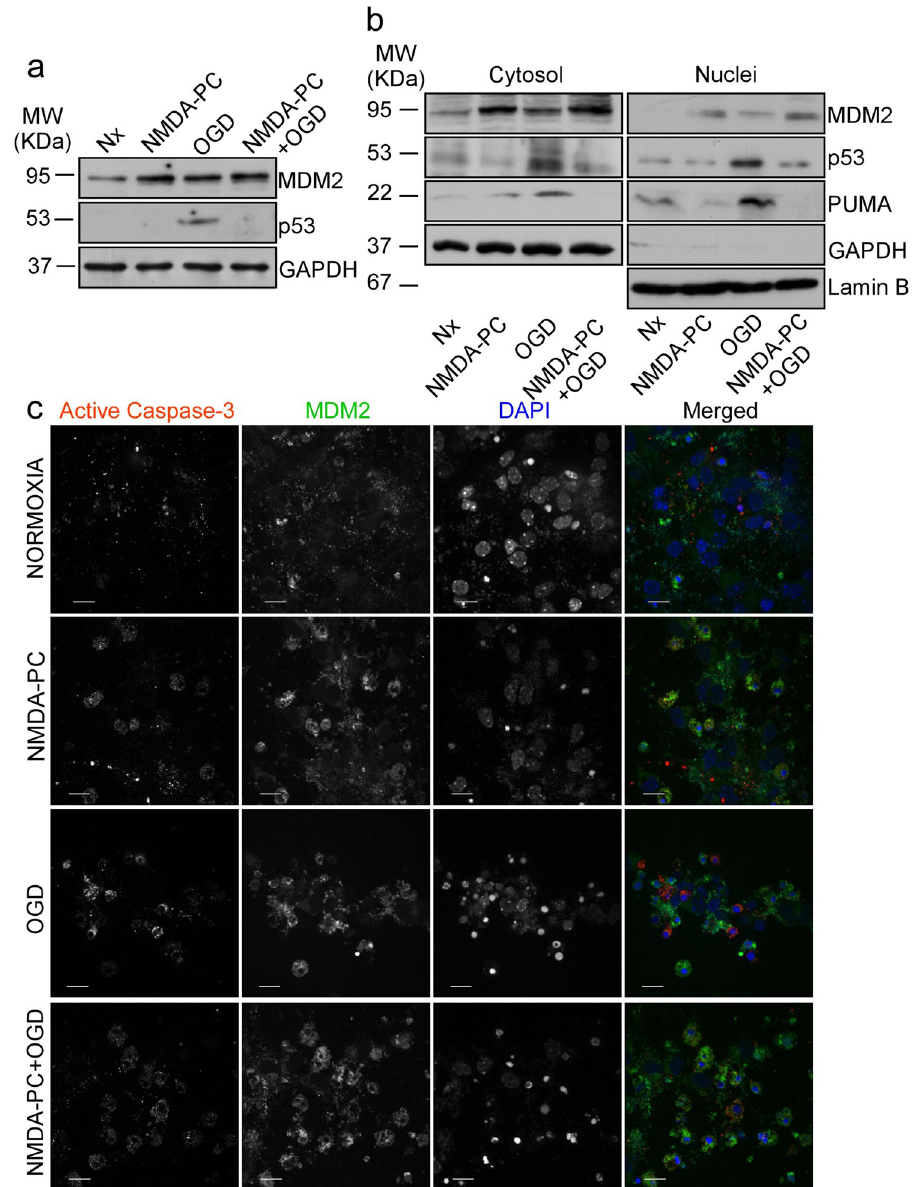
Figure 4. NMDA-PC increases MDM2 protein levels and promotes p53 nuclear and cytosolic destabilization. Mouse cortical neurons (9–10 DIV) were exposed to a validated in vitro model of NMDA-PC (Table 1). Levels of the E3-ubiquitin ligase MDM2 and p53 were detected by western blotting. GADPH protein levels were used as loading control. A representative western blot image is shown out of three. ( a ) NMDA-PC increased MDM2 levels at 4 hours after OGD. ( b ) This effect occurred in both nuclei and cytosol, together with a decrease in levels of p53 and its target PUMA. Lamin B and GAPDH protein levels were used as nuclear and cytosolic loading control, respectively. ( c ) Confocal images showed that NMDA-PC increased MDM2 levels expression (green) after OGD, which preferentially located in the nucleus (DAPI; blue), and prevented OGD-induced activation of caspase-3 (in red). Scale bar: 20 μ m. Relative percentages of neurons with active Caspase-3/MDM2-staining are presented in Supplementary Fig. S1. Relative protein abundances quantification Fig. 4a and Fig. 4b are presented in Supplementary Fig. S2 and that “full-length blots/gels are presented in Supplementary Fig.